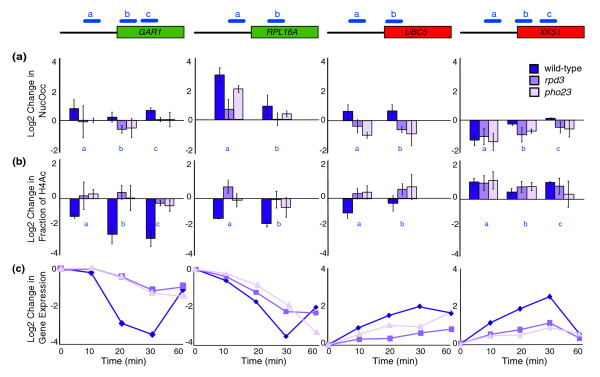
Rpd3p mediates stress-dependent changes in histone acetylation. Changes in nucleosome occupancy (NucOcc) and histone H4 acetylation (H4Ac) at specific nucleosomes (blue bars) spanning representative repressed (green) and induced (red) ESR genes shown in Figure 2 was measured in wild-type, rpd3Δ and pho23Δ cells responding to 0.4 mM H2O2 treatment (see Materials and methods for details). The log2 changes in (a) nucleosome occupancy and (b) fraction of nucleosomes acetylated on H4 following H2O2 exposure is shown for each gene. Error bars represent the range of two replicates for wild type or the standard deviation of at least three experiments for rpd3Δ and pho23Δ. H4 acetylation levels were normalized to levels of nucleosome occupancy to capture the change in the fraction of acetylated nucleosomes. (c) Expression changes of each gene as measured by microarray experiments at 10, 20, 30, 40, and 60 minutes after H2O2 treatment in wild-type, rpd3Δ and pho23Δ cells, according to the key shown.